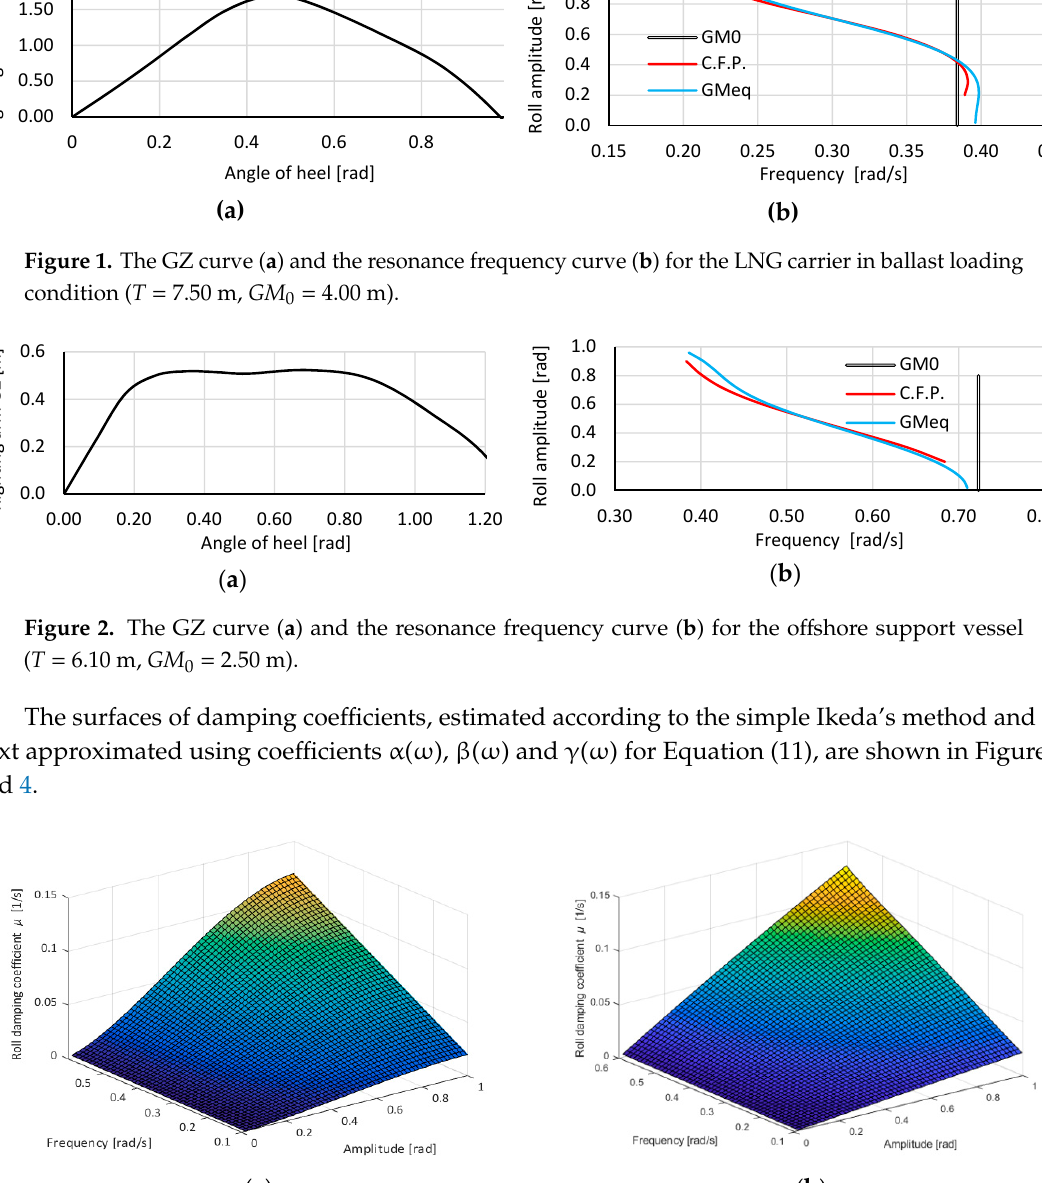
( a ) ( b ) Figure 4. Damping coefficients for the offshore support vessel ( T = 6.10 m, GM 0 = 2.50 m, C B = 0.778, C M = 0.987, bilge keel: l BK = 19.00 m, b BK = 0.30 m) calculated according to the simple Ikeda’s method ( a ) and next approximated using coefficients α ( ω ), β ( ω ) and γ ( ω ) in Equation (11) ( b ). 3.2. Areas of Bistability and Unstable Solution of the Mathematical Model of Rolling For the strongly nonlinear system, the roll spectrum should be developed with the use of a two- dimensional analysis [8]. The result of such calculations for the considered ships in selected loading conditions and assumptions/parameters specified in the previous section are presented in Figures 5 and 6. 0.00.20.40.60.8 1.01.2 0.15